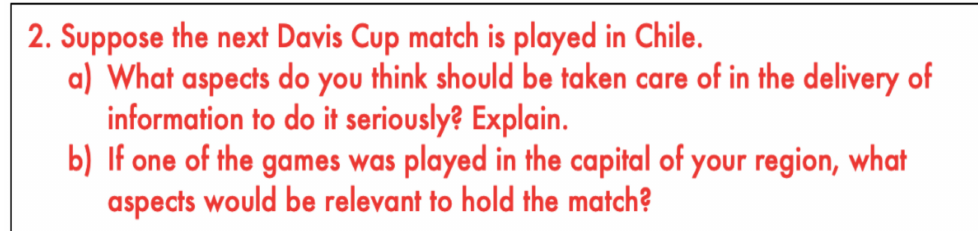
Figure 17. Example of a task with undefined variable (Adapted from [34] (p. 297)). Presence of Variable Types by Educational